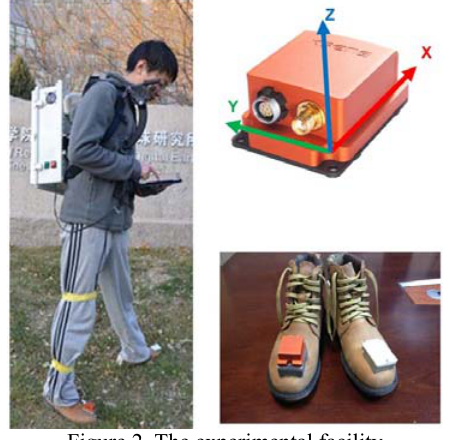
Figure 1. An extended Kalman filter method is adopted in this